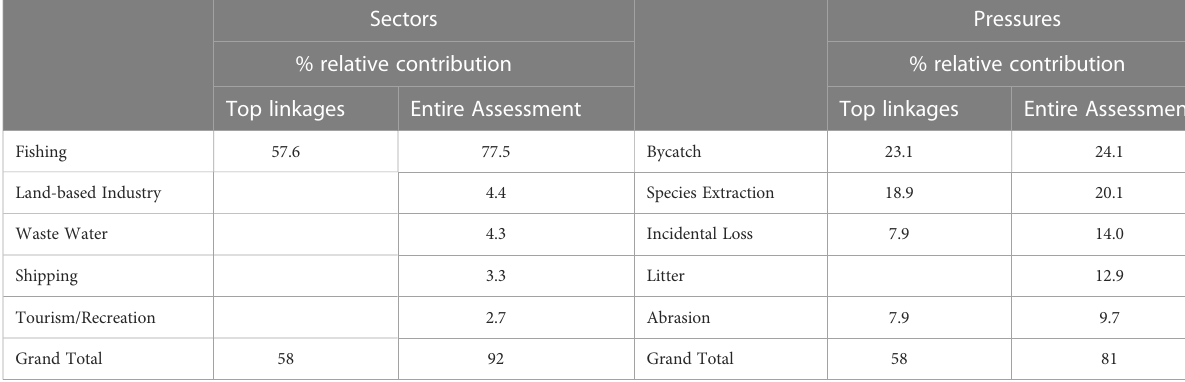
TABLE 8 Relative contribution scores for both the top linkages and the entire